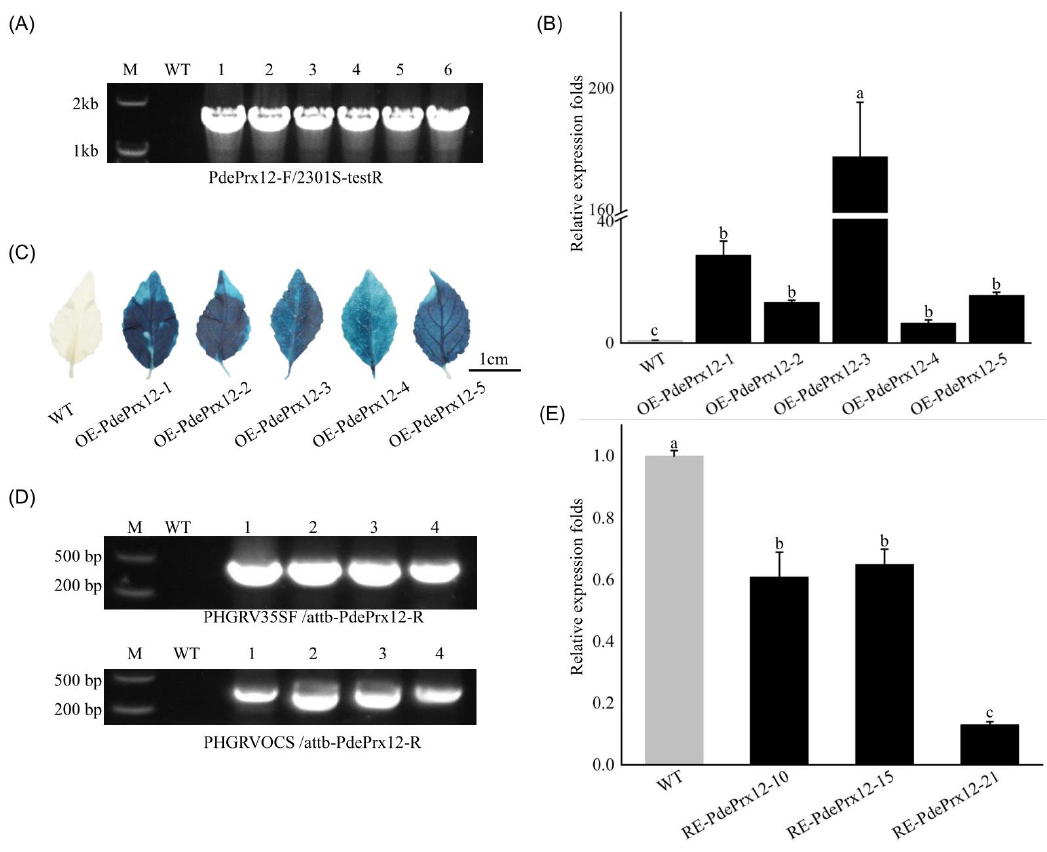
Figure 3. Generation of transgenic poplar lines. ( A ) The presence of the overproducing construct in transgenic poplar. Primers PdePrx12-F/2301S-testR were used for PCR of the OE line, where M rep- resents the marker; WT represents WT NL895 poplar; 1 represents the 2301S-PdePrx12 plasmid; and 2, 3, 4, 5, and 6 are five positive lines of OE-PdePrx12. ( B ) Positive identification of RNA level in PdePrx12 transgenic lines. Relative expression of PdePrx12 in the WT and OE lines. The relative ex- pression level of PdePrx12 in WT was set to onefold. Bars indicate standard deviation ( p = 0.05). ( C ) Comparison of GUS staining between OE lines and WT lines (bar = 1 cm). ( D ) The presence of the gene silencing construct in transgenic poplar. The DNA level of RE-PdePrx12 transgenic lines was positively identified. The primers PHGRV35SF/attb-PdePrx12-R and PHGRVOCS/attb-PdePrx12-R were used for PCR in the RE lines, where M represents the marker; WT represents wild-type NL895 poplar; 1 represents the PHGRV-PdePrx12 plasmid; and 2, 3 and 4 are the three positive lines of RE-